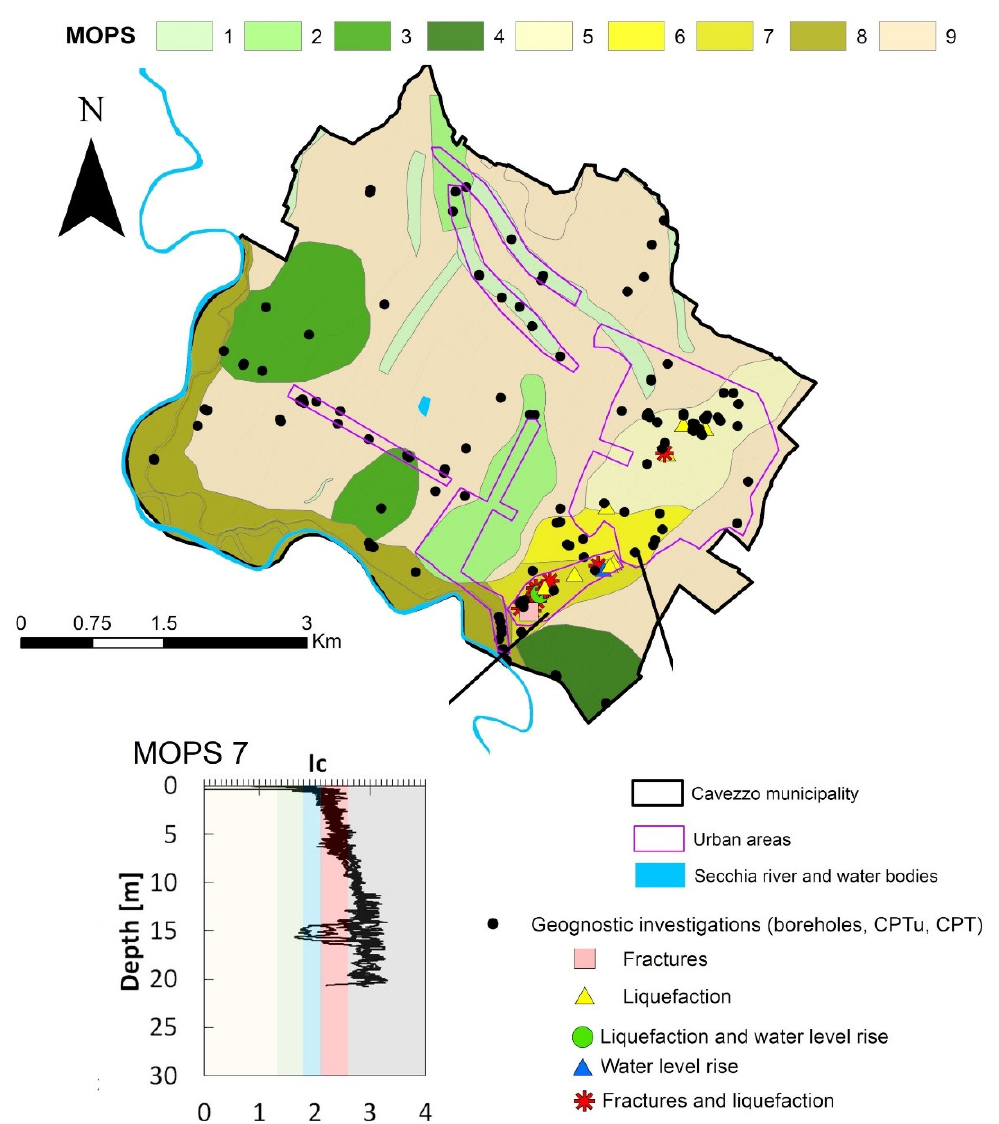
Figure 13. Lithological units (MOPS) in Cavezzo. The Ic trend for MOPS 7 is also reported.